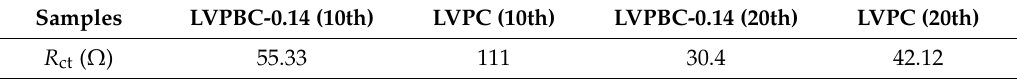
Table 2. R ct fitting values of the LVPBC-0.14 and pristine LVPC composites at different cycles.